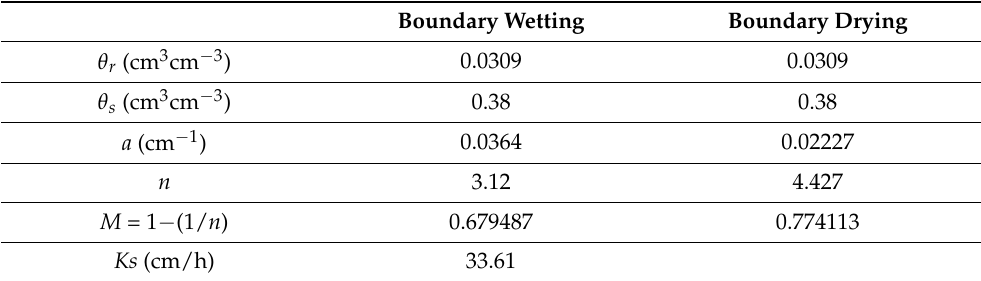
Table 1. The values of the parameters of the Mualem–van-Genuchten model obtained according to a curve-fitting procedure (RETC program) on experimental measurements and the measured